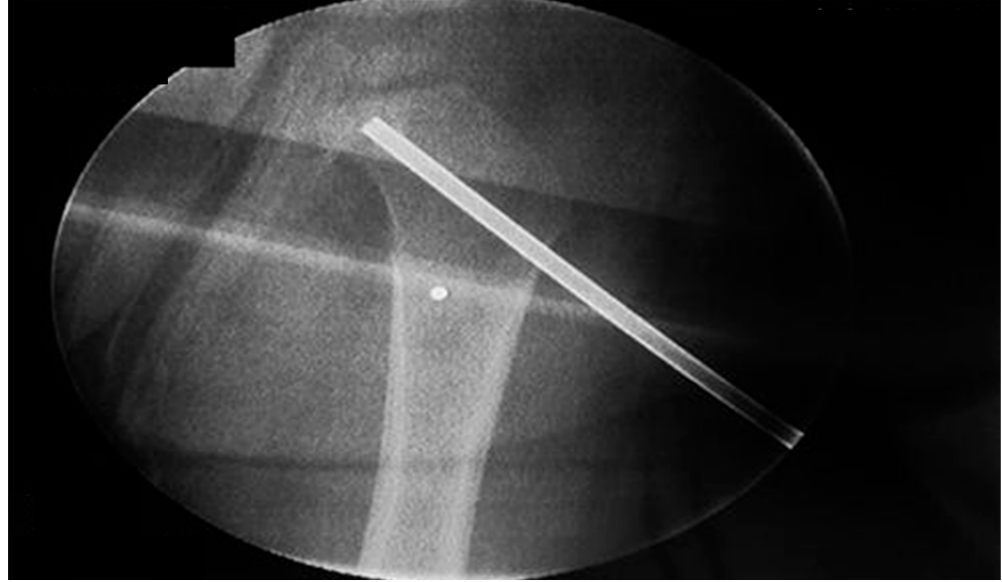
Figure 3. Image intensifier control during surgical closed needle biopsy and drainage.